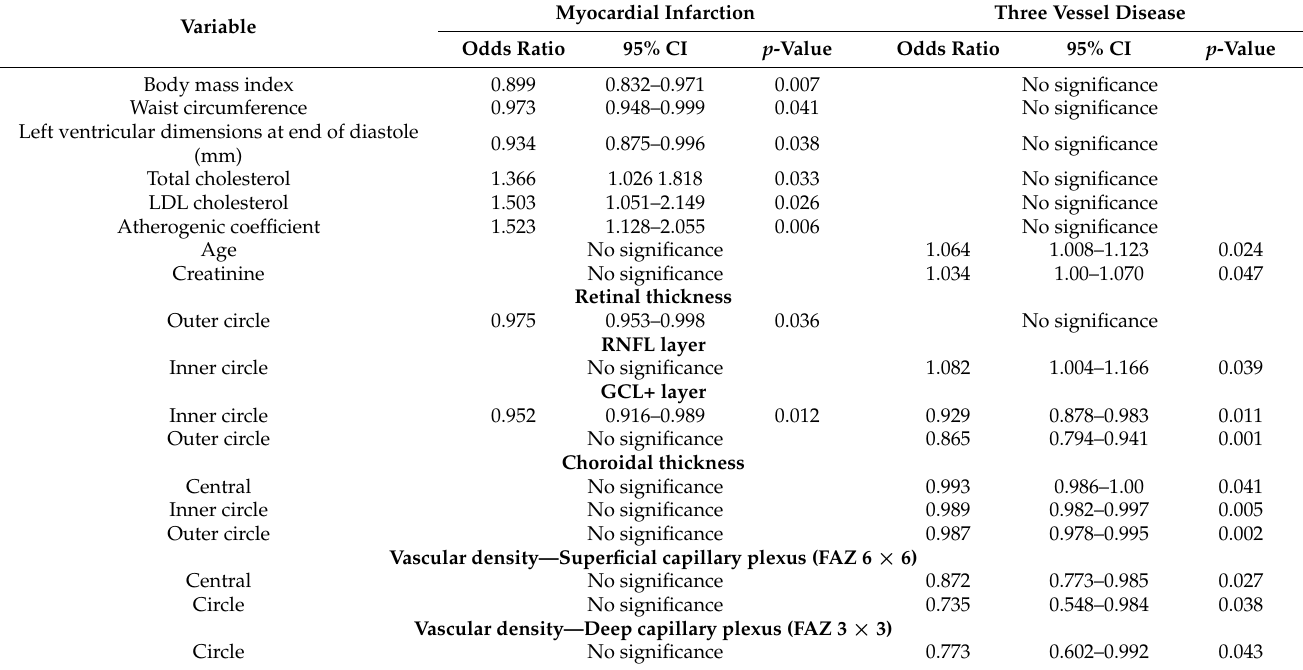
Table 2. Univariate binary regression analysis for development of three vessel disease and acute myocardial